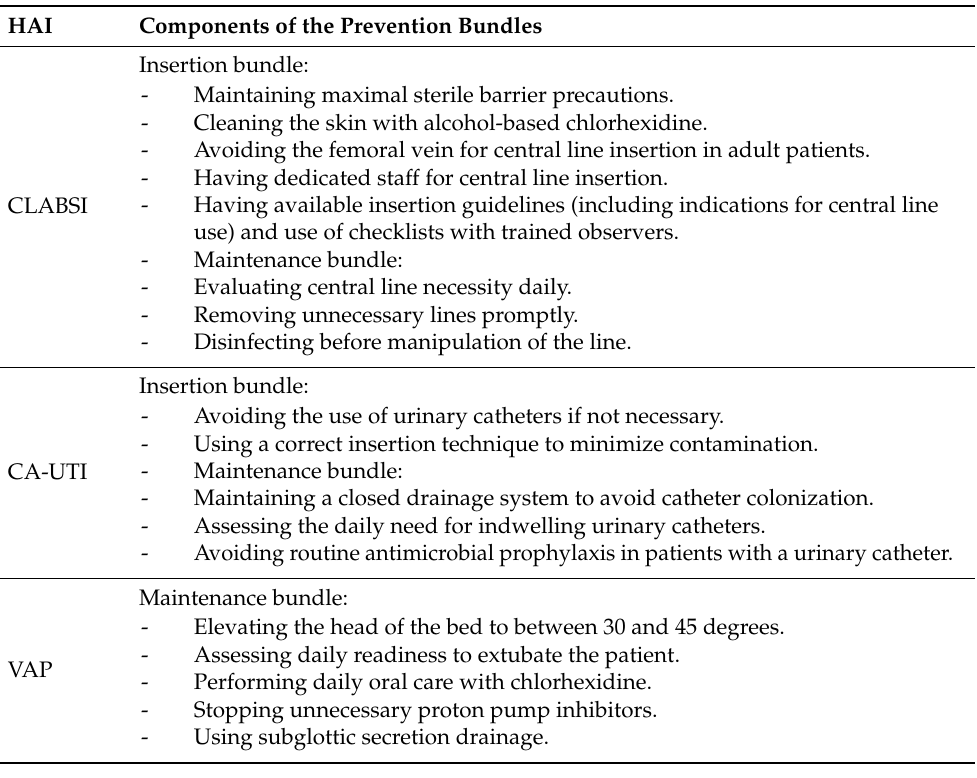
Table 1. Components for the prevention bundles